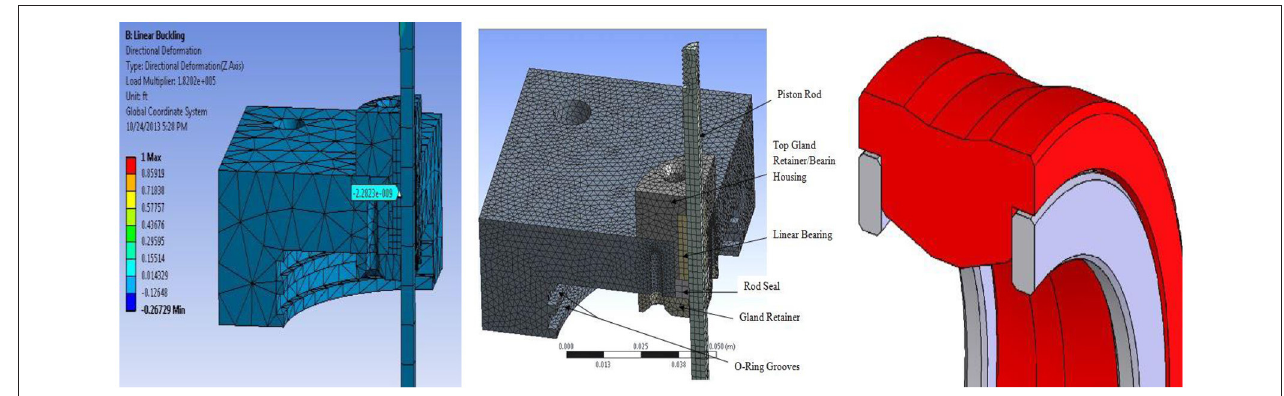
Figure 3 shows how the piston rod is retained by the gland assembly. The gland assembly consists of a linear bearing